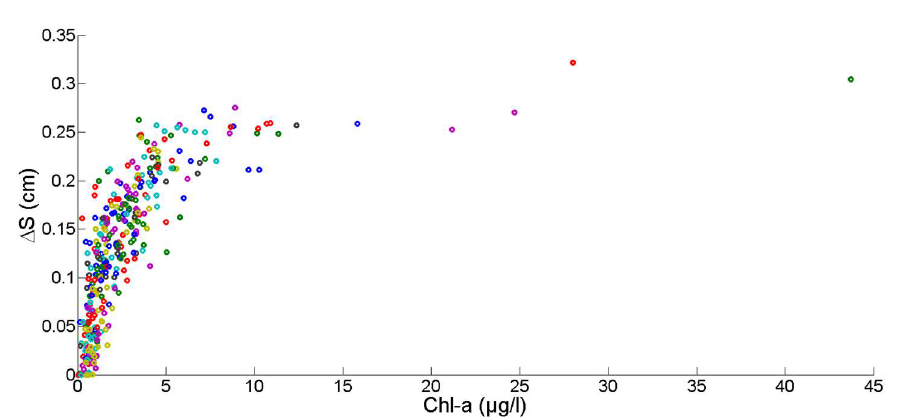
Figure 5. Scatter diagram of the variations of mussel shell length ( ∆ S ) vs. Chlorophyll a for 10 days periods during the 17 year time series (each color represents a year of the 1996–2012 time-series).